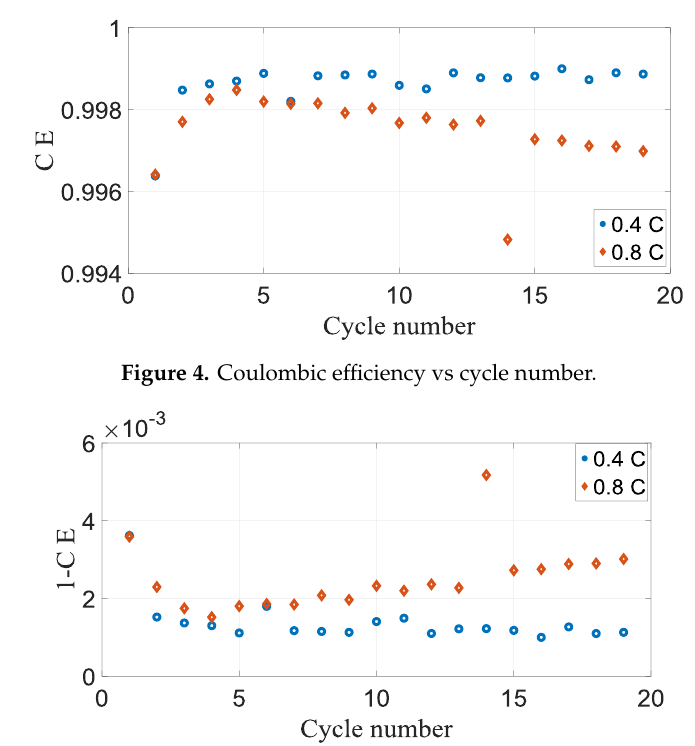
Figure 5. Coulombic inefficiency vs cycle number.